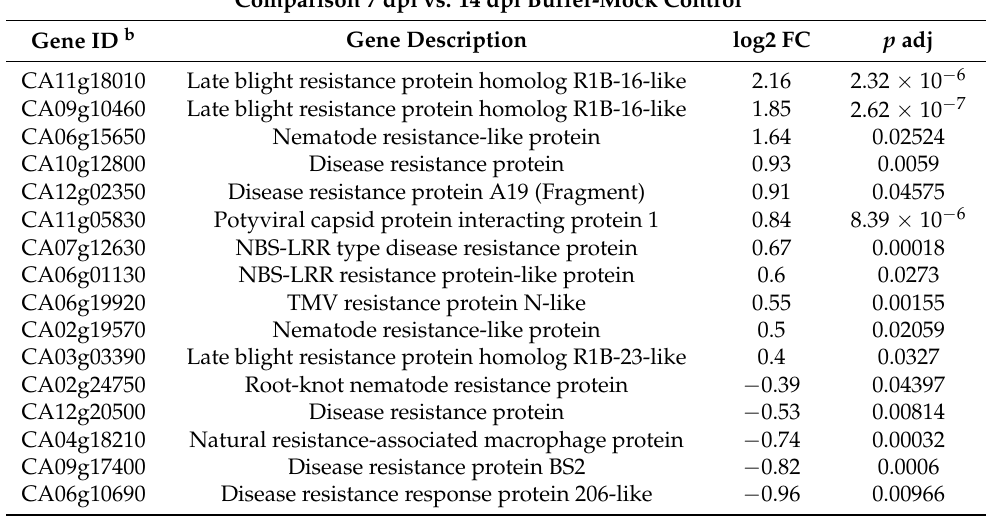
Table 3. Tobacco etch virus (TEV) strain-specific disease-related differentially expressed genes (DEGs) in Capsicum annuum plants from 7 to 14 days post-inoculation (dpi). Comparison 7 dpi vs. 14 dpi Buffer-Mock Control